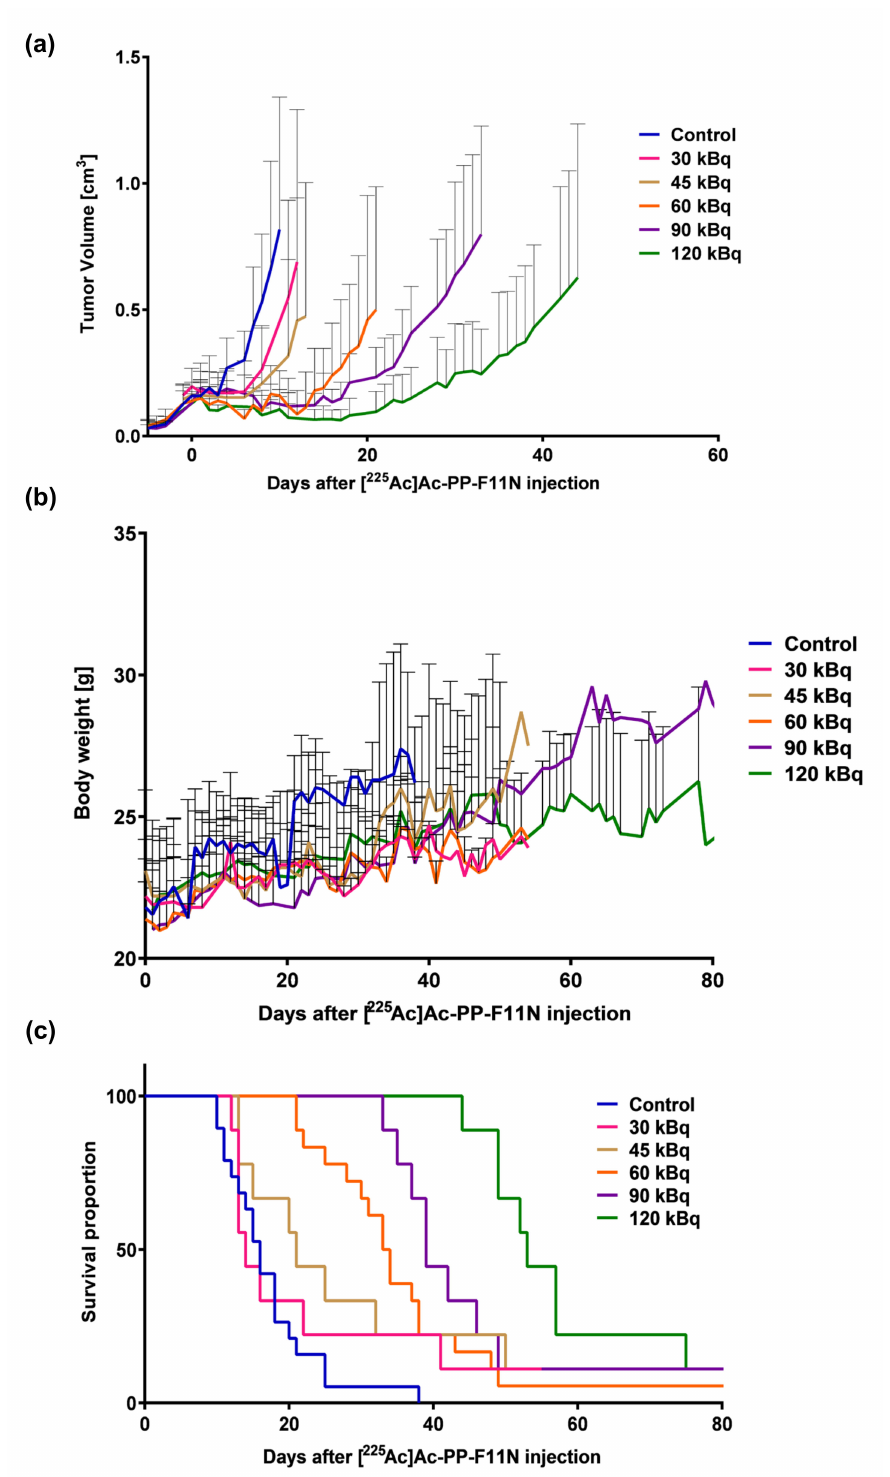
Figure 3. Tumor growth inhibition and prolonged life span in [ 225 Ac]Ac-PP-F11N-treated mice. After tumor implantation, PBS or 30, 45, 60, 90, and 120 kBq of purified [ 225 Ac]Ac-PP-F11N was administrated into A431 / CCKBR tumor-bearing nude mice groups as indicated ( n = 9, except for the control and 60 kBq group for which n = 18). The tumor growth ( a ) and the body weight curves ( b ) in di ff erent treatment groups. Values are shown as mean ± SD. ( c ) The survival rates presented as Kaplan-Meier curves of the control and [ 225 Ac]Ac-PP-F11N-treated